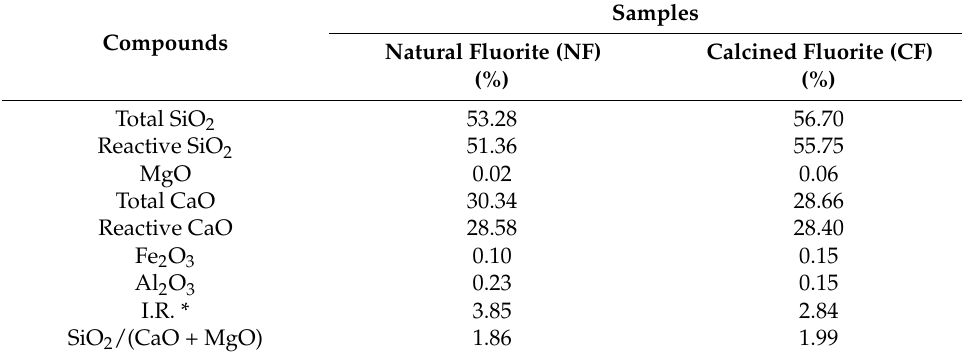
Table 2. Chemical composition of the NF and CF samples